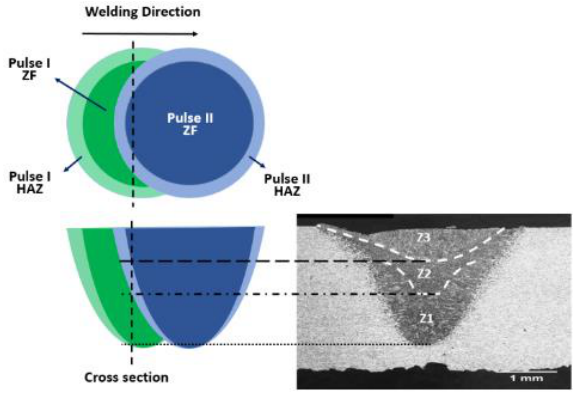
Figure 3. Schematic illustration of the pulse overlapping and its effect on the weld bead [21]. Copyright 2021 Elsevier .